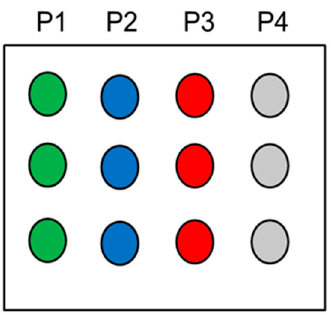
Figure A3. Spotting layout of DNA microarray: Cy5-labeled P1 probe, positive control ( green circles ); P2 probe + Cy5-labeled P2 target, hybridization control ( blue circles ); P3 probe + Cy5-labeled P3 target, PCR product ( red circles ); P4 probe, negative control ( grey circles ).